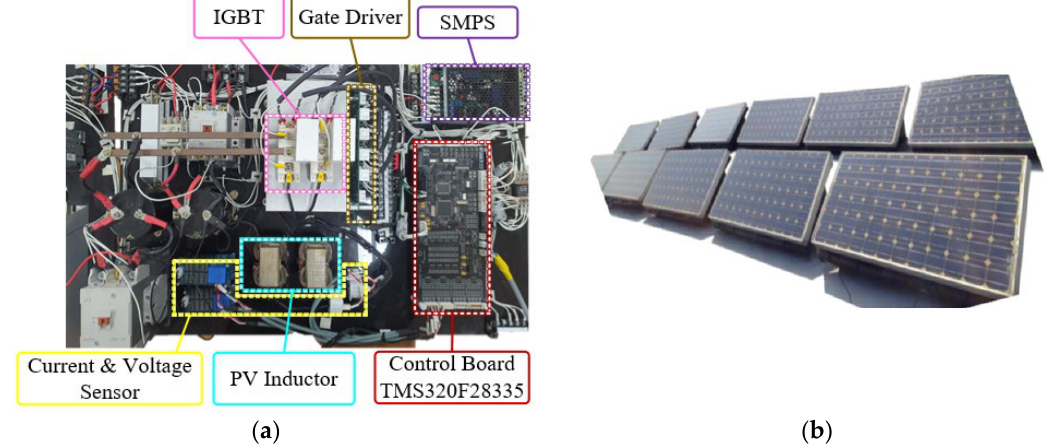
Figure 18. Photovoltaic (PV) generation system: ( a ) PV converter; ( b ) PV panels.